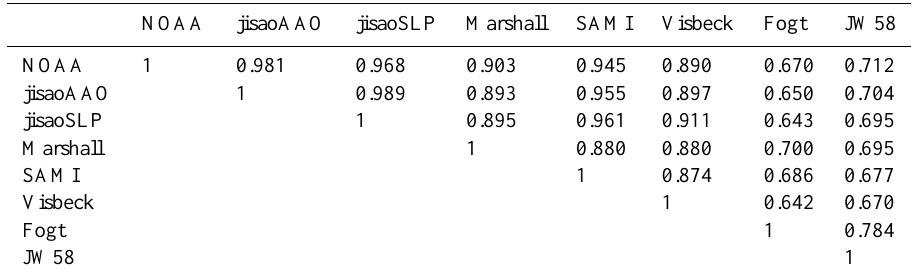
Table 2. Correlation between various SAM indices at a seasonal resolution (normalised for the period where all indices are available: 1979–2002). NOAA jisaoAAO